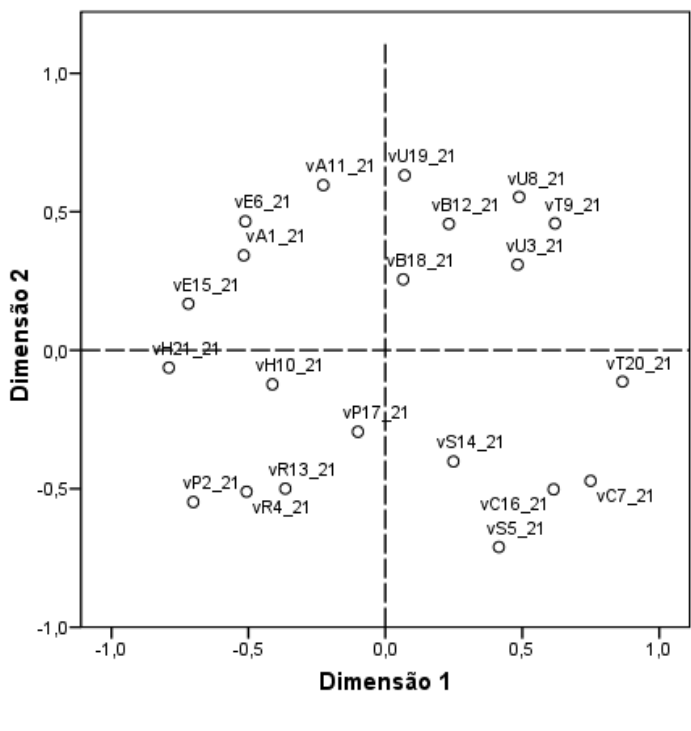
Figura 6. WCMDS por itens do PVQ-21